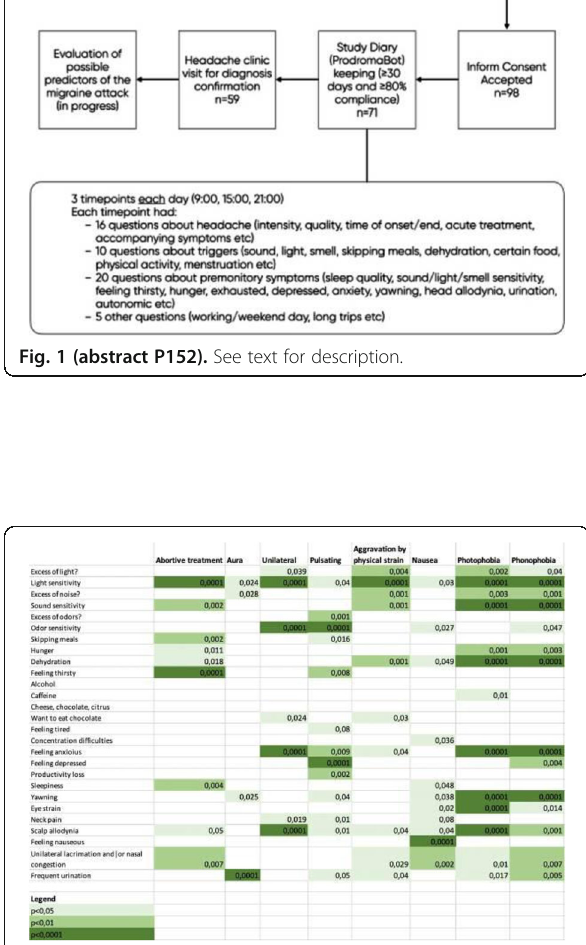
Fig. 2 (abstract P152). See text for